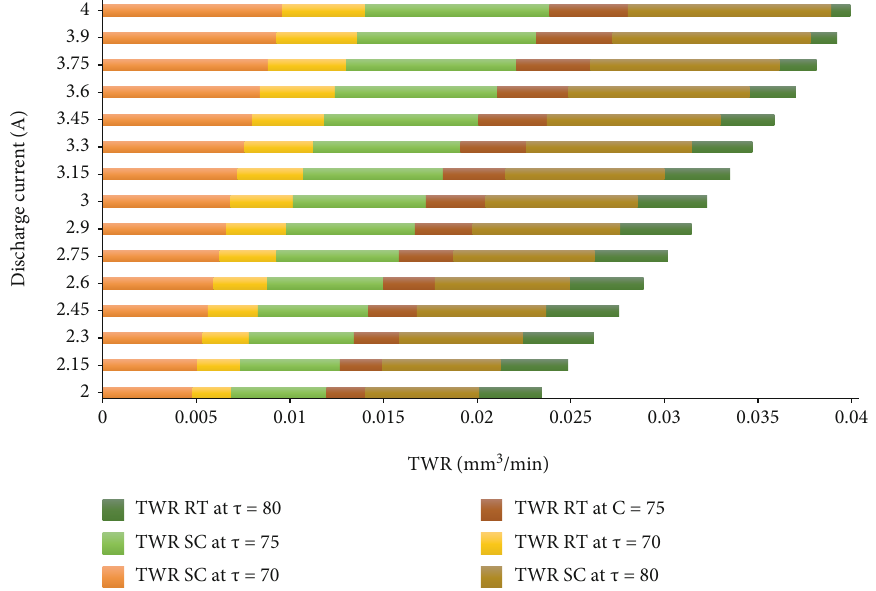
Figure 9: TWR vs. discharge current for two types of electrodes at T